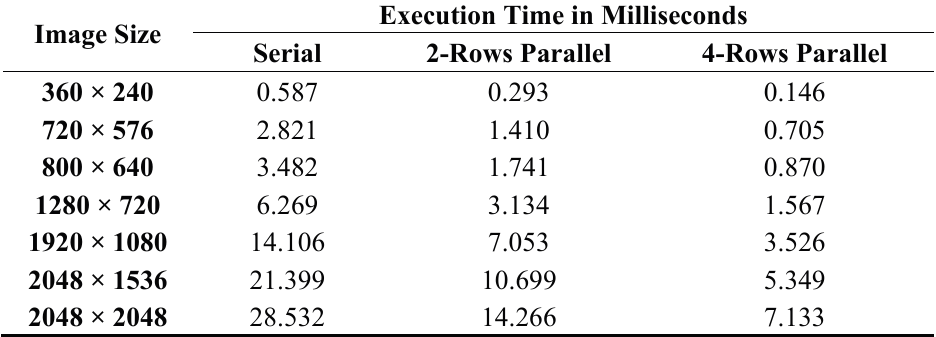
Table 2. Comparative timing results of integral image computation for Serial, 2-rows and 4-rows parallel prototype implementations on a Xilinx Virtex-6 XC6VLX240T FPGA for some common image sizes with 8-bit